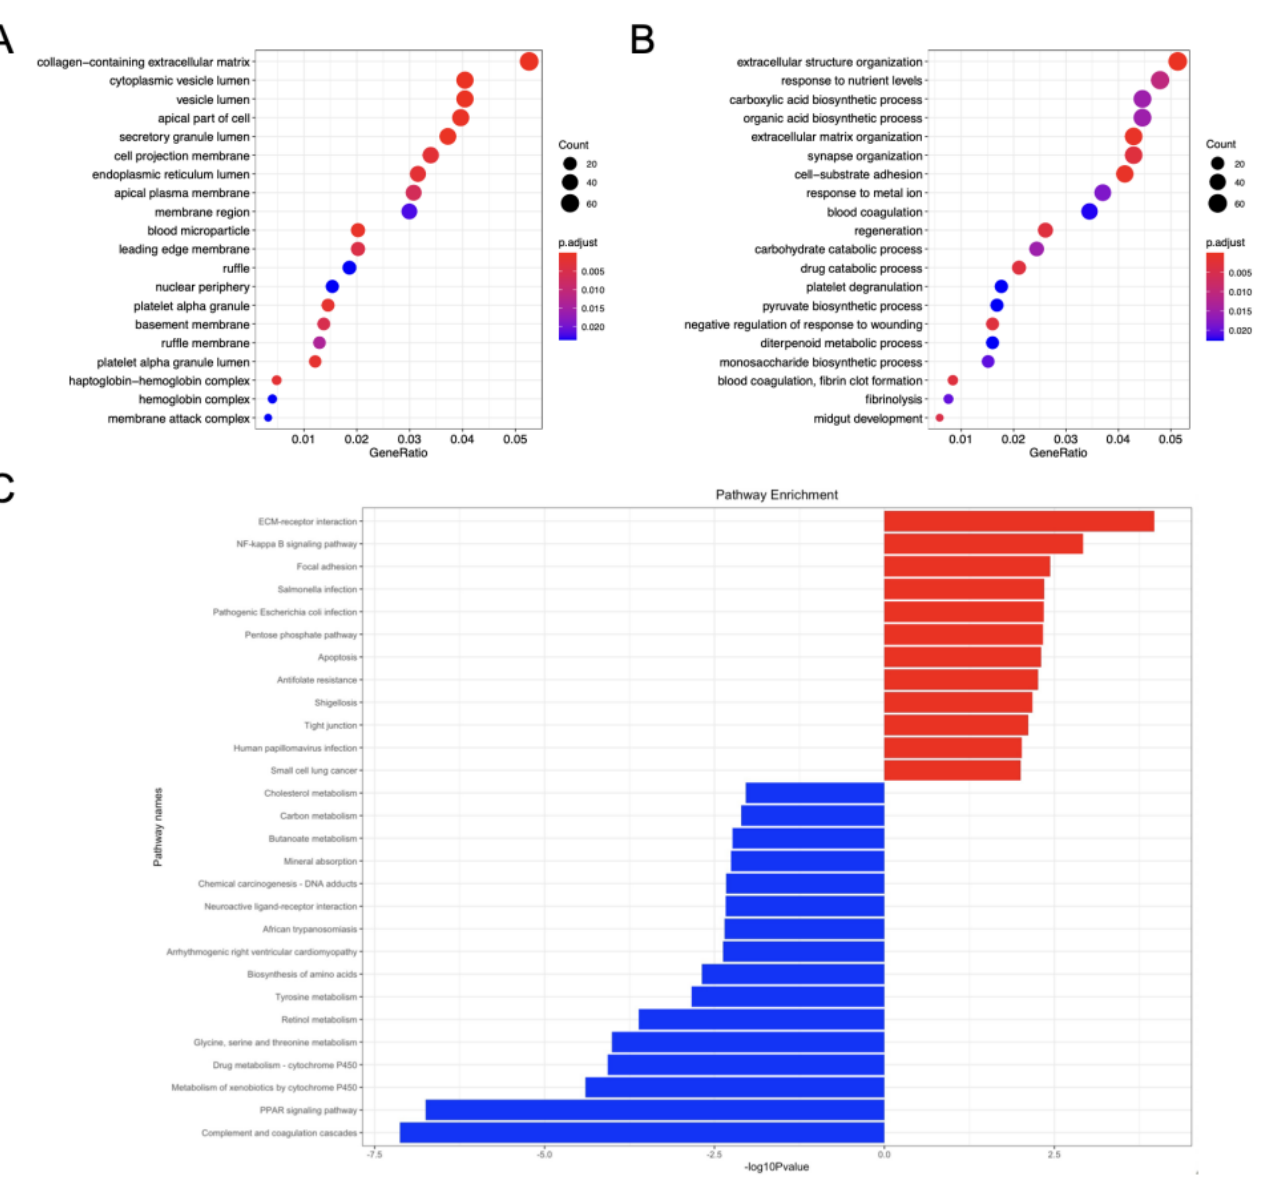
Figure 3. Analysis of function and enrichment of GSE-DEGs. ( A ) CC category of GO annotation diagram of GSE-DEGs. ( B ) BP category of GO annotation diagram of GSE-DEGs. X-axis: enrichment factor (ratio of number of entries in the foreground gene set to number of background genes enriched in the same entry). Y-axis: enrichment pathways. The number of genes in the pathway determines dot size in direct proportion. The color of the dots (from red to blue) corresponds to the q-value reduction in sequence, although the difference is more significant. ( C ) Bar chart representing KEGG enrichment: enriched pathways of up-regulated genes (red) and enriched pathways of down-regulated genes